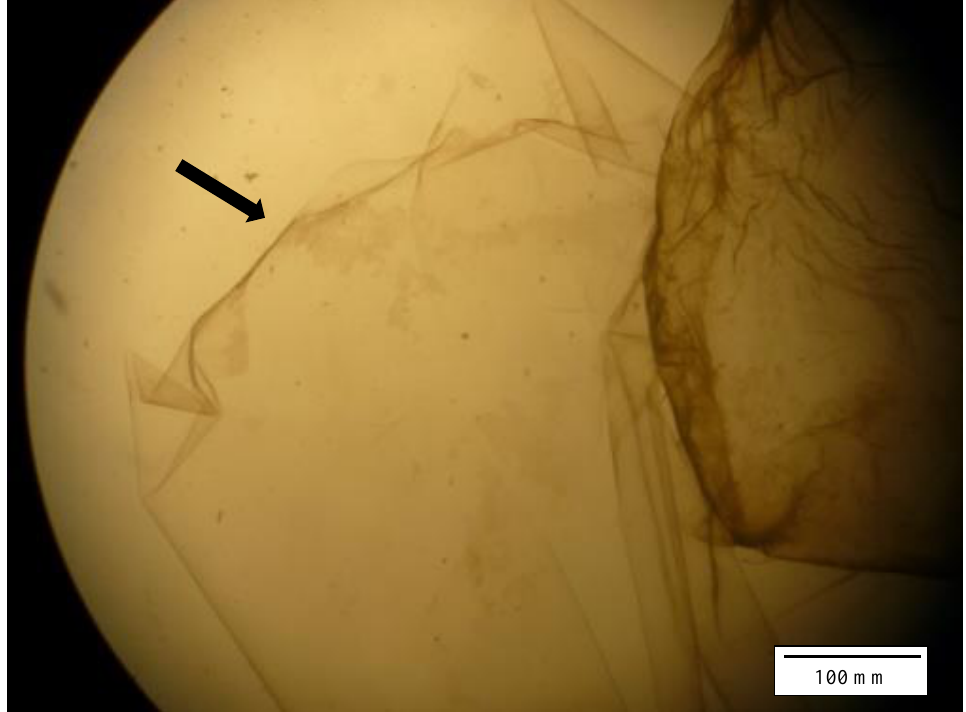
Figure 1. Separated perivitelline membrane of a chicken egg under the stereo microscope (x2): Arrow indicates inner part.